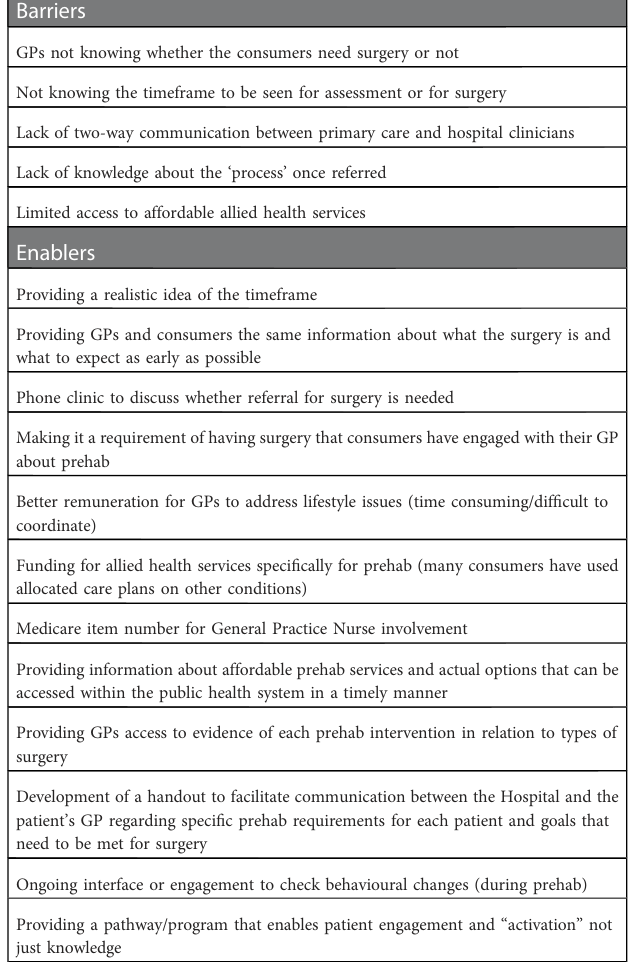
TABLE 1 Barriers and enablers to prehabilitation as identi fi ed by primary healthcare providers.